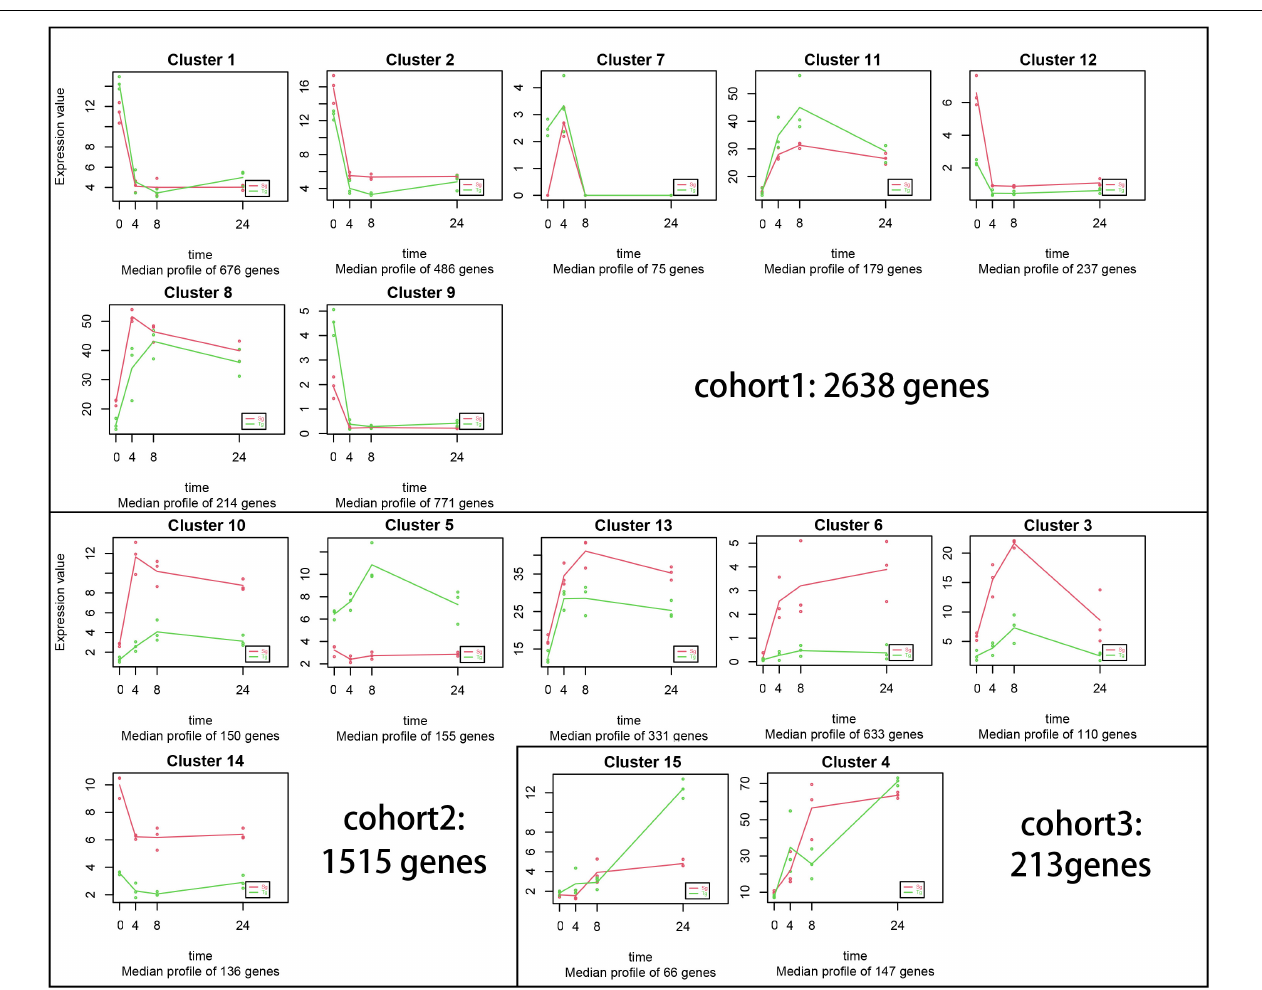
FIGURE 4 | Gene co-expression and cluster analyses using MaSigPro software. Each plot represents similarly expressed genes during the cold treatment (0, 4, 8, and 24 h). R 2 > 0.6. These plots are grouped into cohorts 1, 2, and 3 according to the expression